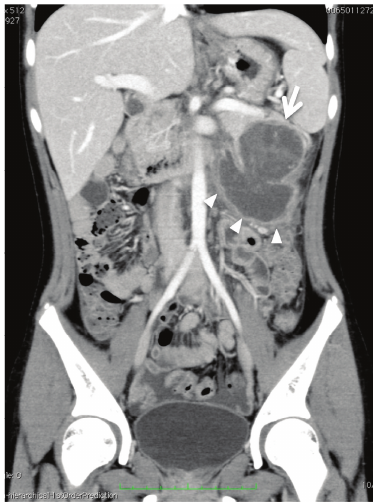
Figure 1: Urgent CT of acute abdomen. A cystic tumor is shown (arrow) in the pancreatic tail and fluid collection (arrowhead) below it. CT also revealed fluid retention in the pelvis. These findings sug- gested the rupture of tumor and hemoperitoneum.